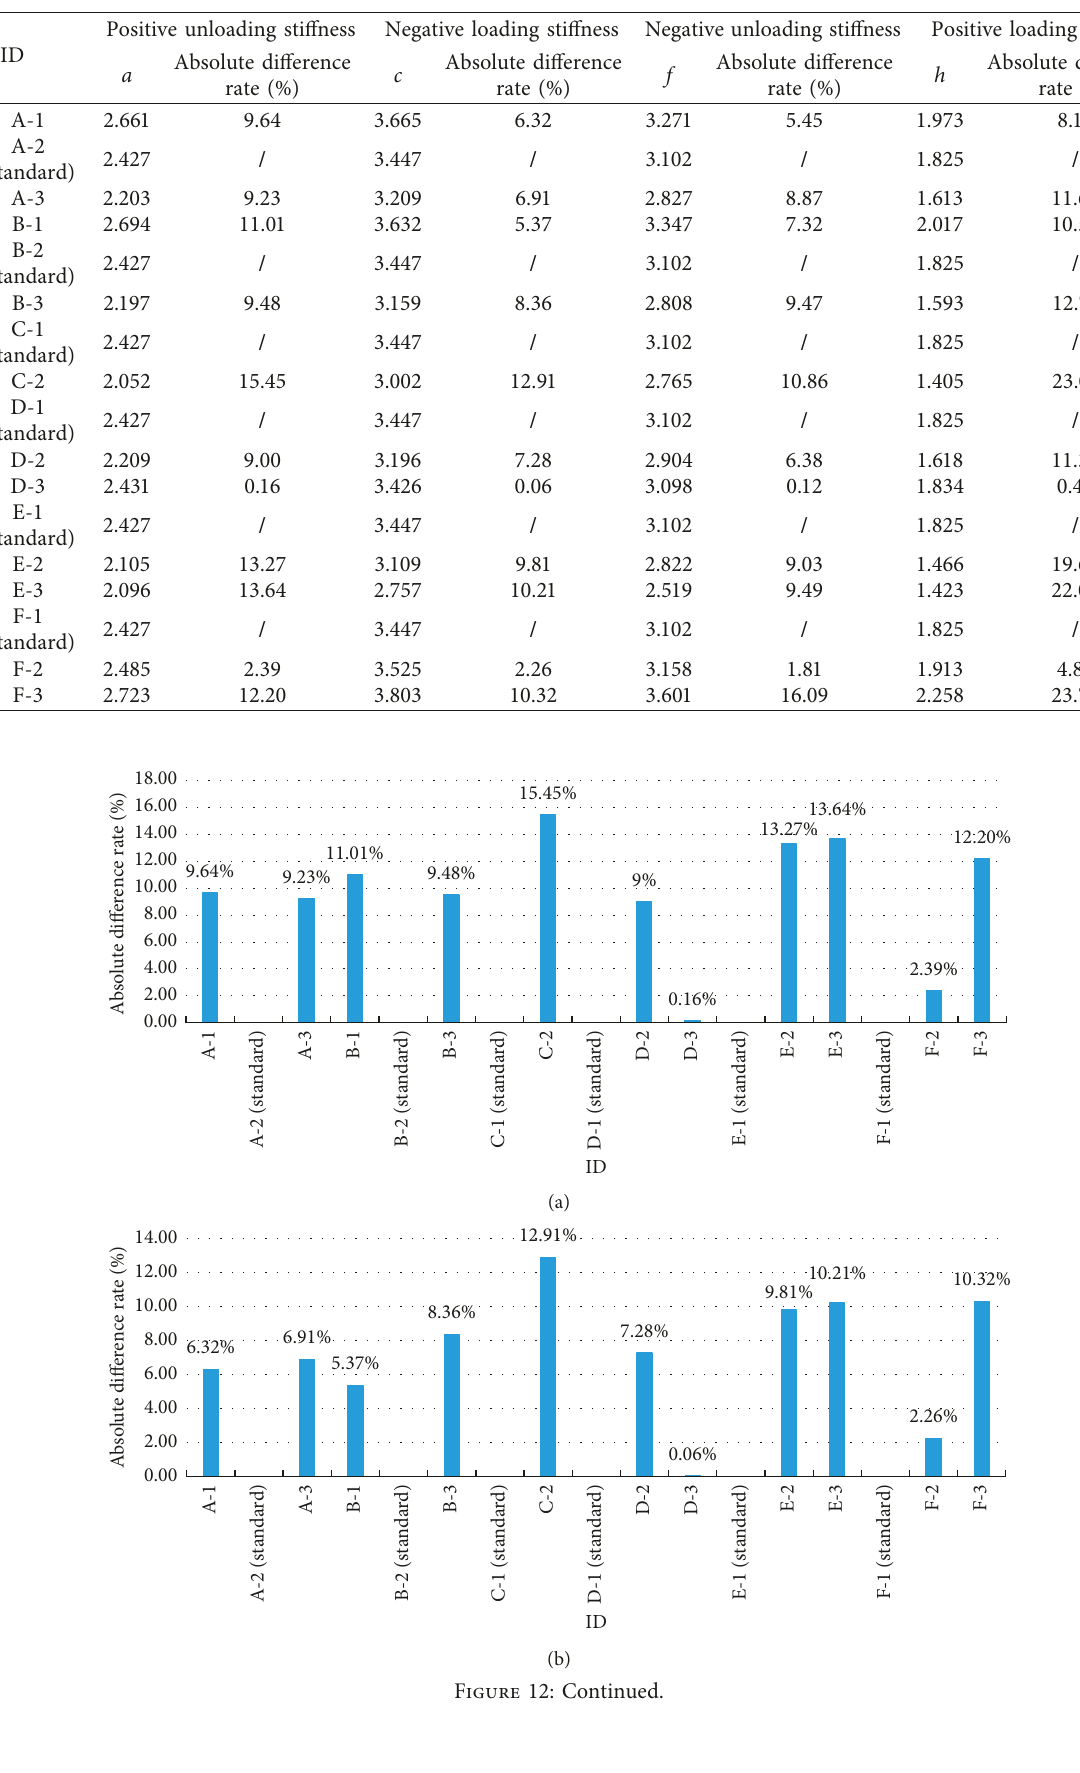
Table 5: Deterioration comparison of positive and negative